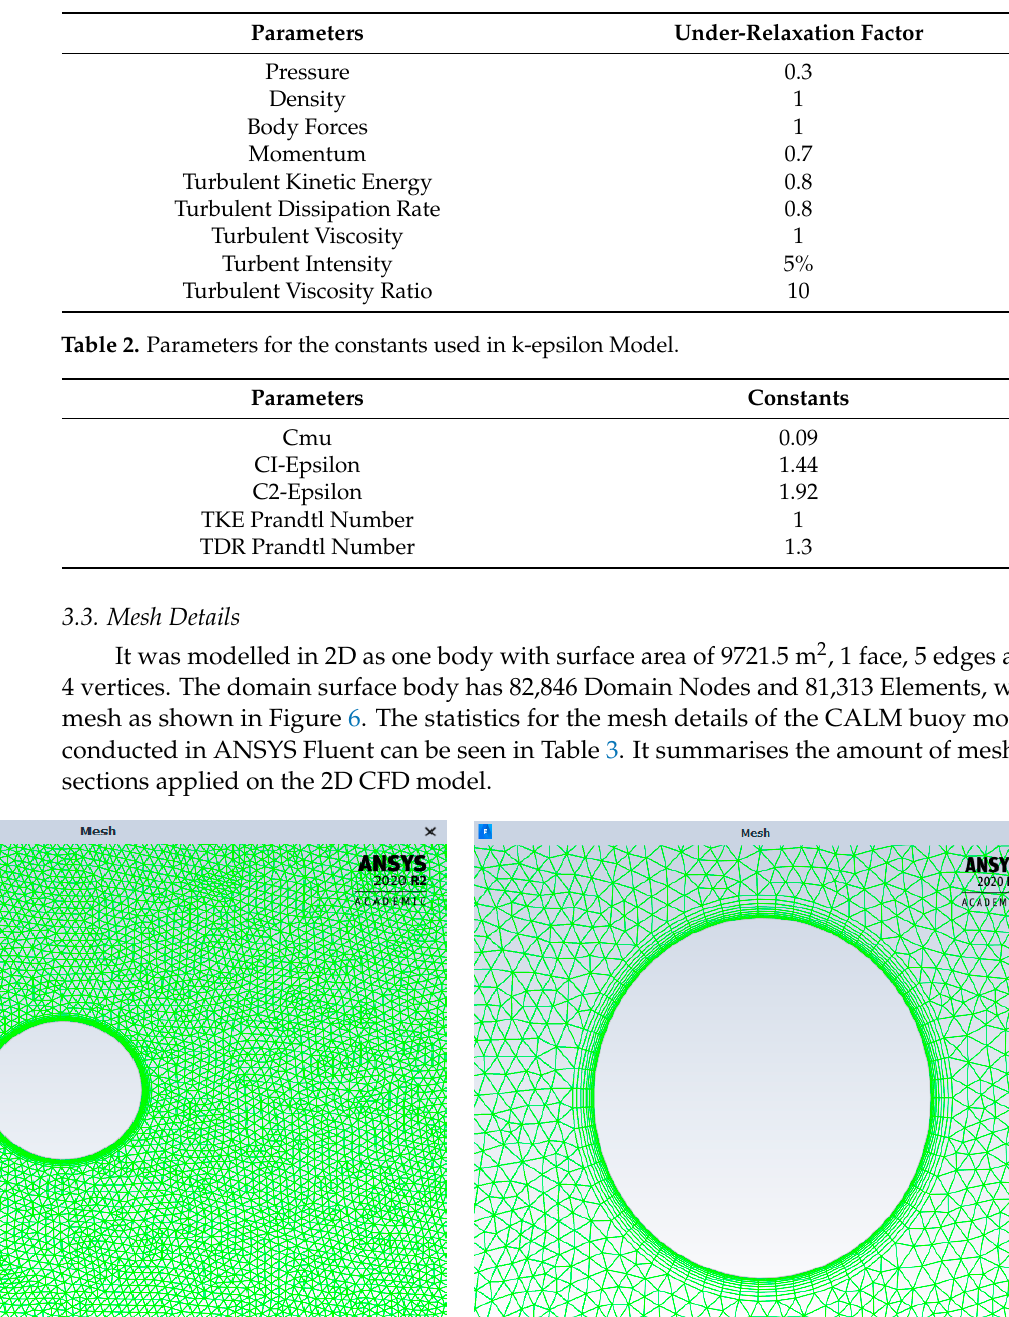
Table 1. Velocity parameters for inlet and Under-relaxation factor for the CFD model.